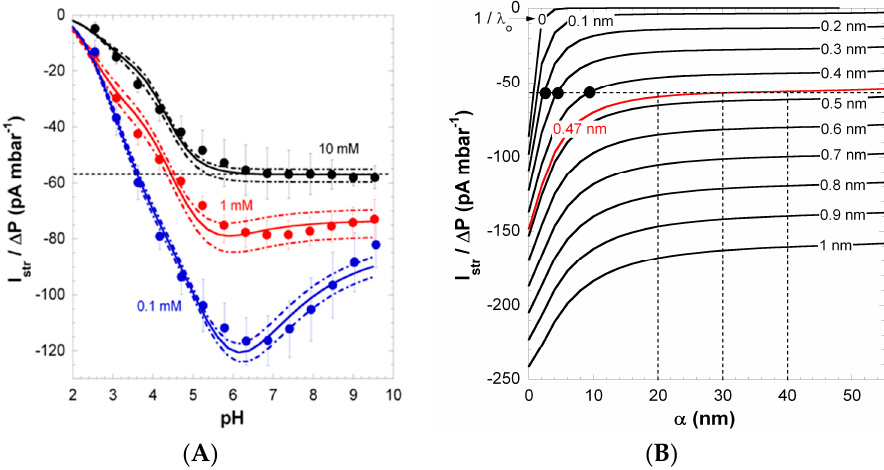
Figure 3. ( A ) Pressure-normalized streaming current, I str { ∆ P , for PAA films as a function of pH in 0.1, 1 and 10 mM KCl solutions (indicated). Experimental data are represented by symbols. Solid and dotted lines were calculated on the basis of the theory by adjustment of the pH- and ionic-strength dependence of the interphasial diffuseness α that best brackets experimental values (dotted lines). ( B ) Dependence of I str { ∆ P on α and 1 { λ o at 10 mM KCl concentration under condition where full dissociation of the film charges is reached (pH > 6). For each 1 { λ o value tested, the value adopted for the charge density ρ o { F in the film is that which fits the surface conductivity K σ at large pH (see Figure 2). The unambiguous evaluation of 1 { λ o is done upon analysis of the intersection points between I str { ∆ P vs. α curves with the I str { ∆ P value measured at large pH in 10 mM KCl (dotted horizontal line in panel A and B ), with as result 1 { λ o = 0.47 nm. The corresponding range of α consistent with I str { ∆ P at large pH in 10 mM KCl is then straightforwardly determined (see vertical dotted lines). The full black circles correspond to conditions that do not allow recovery of the I str { ∆ P vs. pH curve displayed in panel A (which was verified from theoretical simulations). Reprinted from [26]. Copyright 2011 with permission from